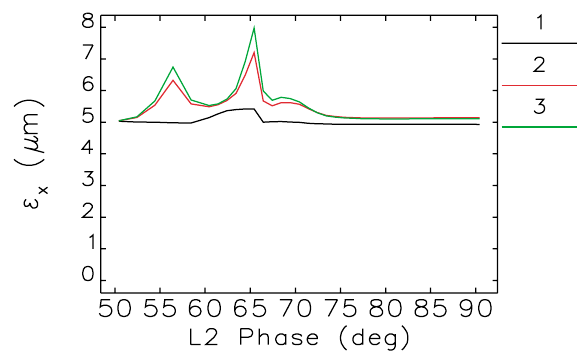
FIG. 11. (Color) Normalized rms horizontal emittance as a func- tion of phase of the precompressor accelerator without CSR in drifts (1), with CSR in drifts using the overtaking length as the exponential decay length (2), and with CSR in drifts using Saldin’s Eqs. (53) and (54)